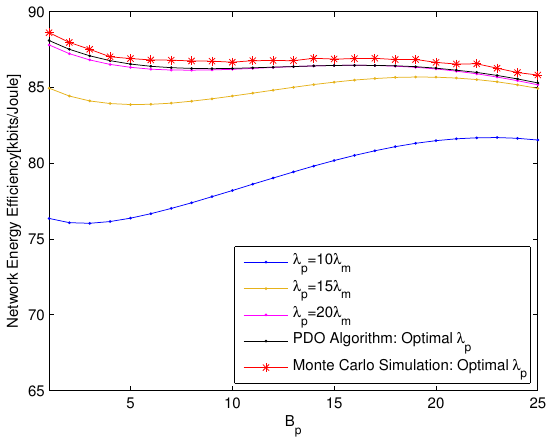
Figure 4. The network EE versus B p with λ u = 0.0018.